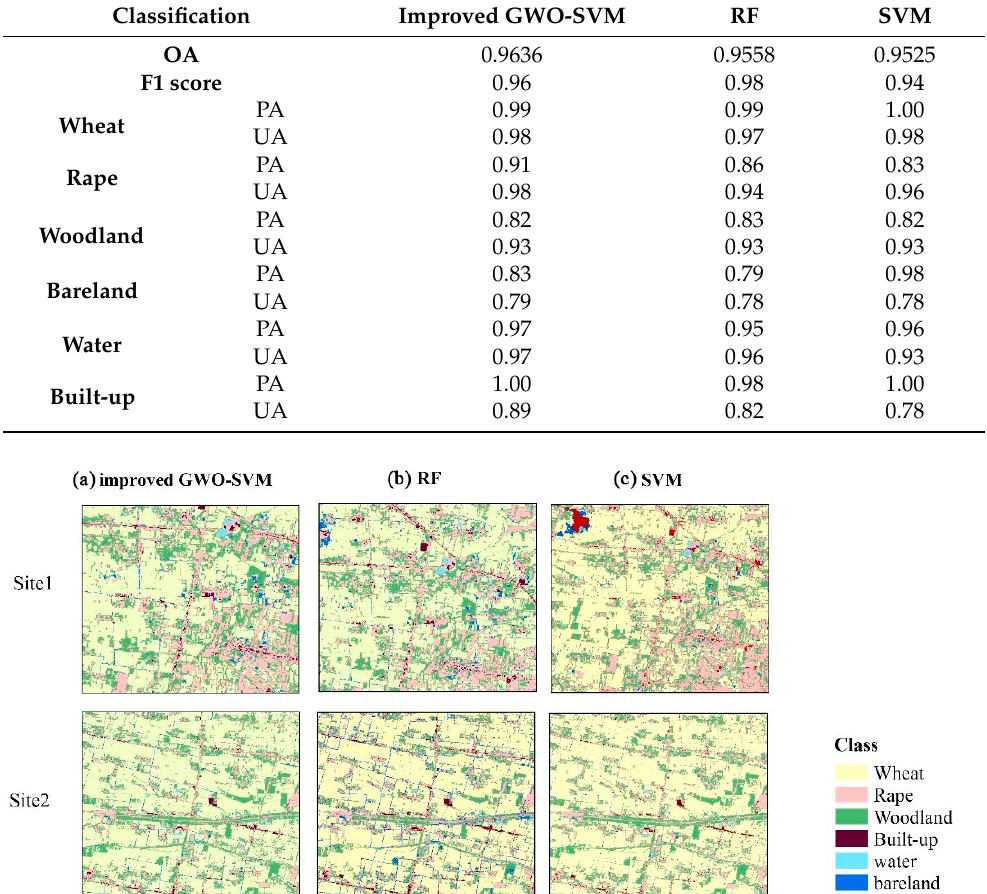
Table 6. The classification accuracy for improved GWO-SVM, RF and SVM.